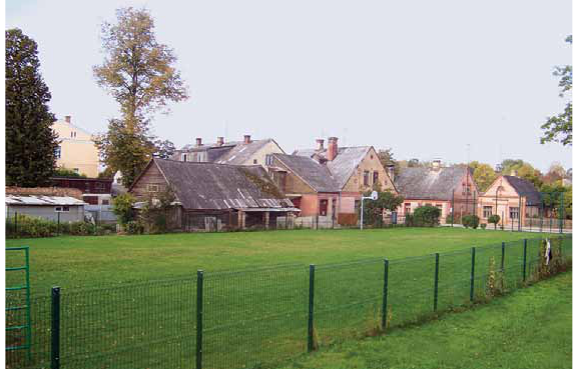
Fig. 4. Thanks to the initiatives of main architect of the town (architect a. Paklons), in the lost historic construction sites a lawn is being cultivated, so maintaining view lines to the roof landscape and the building structure of the old Town.